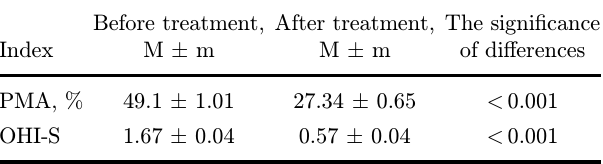
Fig. 3. The laser action of \FotoSan" after tha application of the photosensitizer.